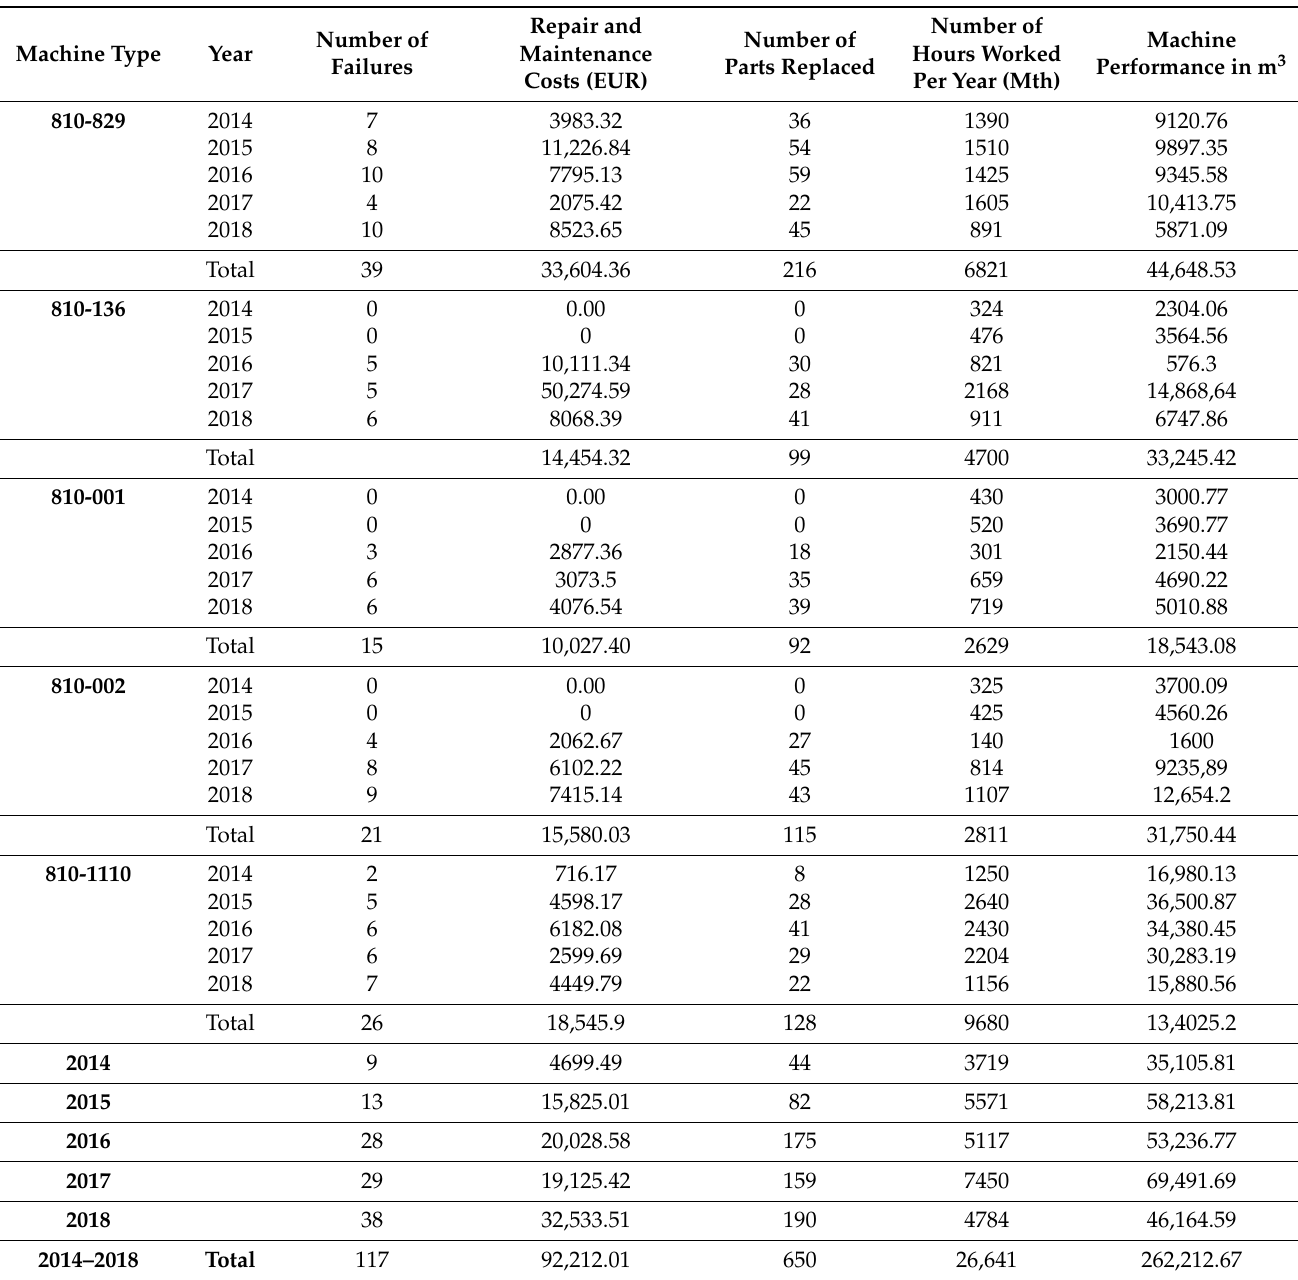
Table 5. Operational data monitored by